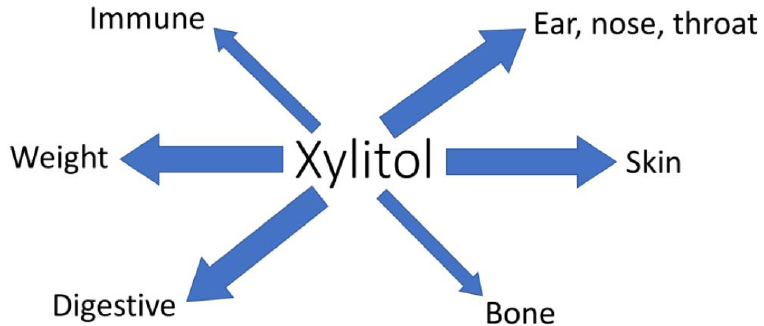
Figure 3. Summary of non-dental health benefits of xylitol. Arrow thickness indicates the level of documentation. Thin arrows indicate only in vitro or animal data, while thick arrows indicate some level of human data.